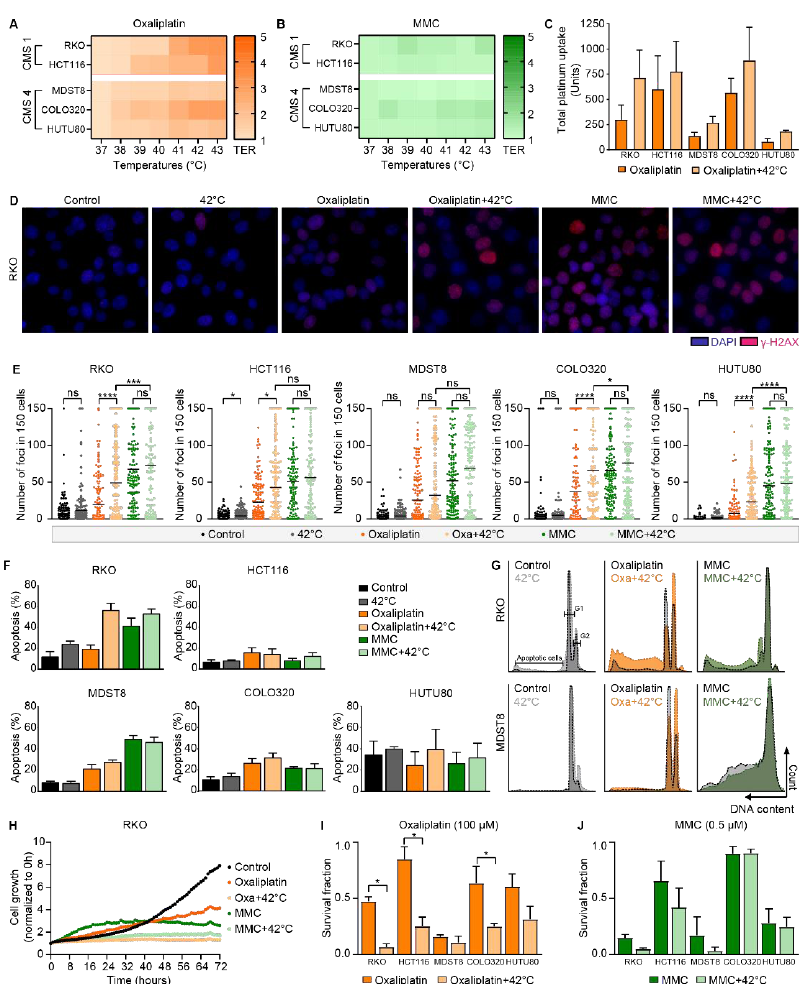
Figure 2. The effect of oxaliplatin is temperature-dependent, mitomycin-C (MMC) is effective at any temperature. To study the temperature-dependent effect of oxaliplatin and MMC, RKO, HCT116, MDST8, COLO320, and HUTU80 cells were exposed to oxaliplatin or MMC under hyperthermic condition for 60 min. Cell viability assays were performed at 48 h after treatment with oxaliplatin ( A ) or MMC ( B ). Thermal Enhancement Ratio (TER) values are demonstrated by a color gradient: a darker color indicates higher TER values. Data represent the mean of 3 independent experiments. ( C ) The cellular uptake of oxaliplatin was assessed by measuring platinum uptake in cells using the CyTOF at 1 h after treatment. Means ± standard error of the mean of 3 independent experiments are presented. ( D ) DNA double strand breaks were measured by nuclear γ-H2AX staining. Representative pictures of RKO cells stained for γ-H2AX are presented. ( E ) Quantification of induced foci in RKO, HCT116, MDST8, COLO320, and HUTU80 cells. Data present the number of foci in 150 cells from 3 independent experiments. Apoptosis levels ( F ) and cell-cycle distribution ( G ) were studied using the Nicoletti assay, which was performed 48 h after treatment. Means ± standard error of the mean of 3 independent experiments are presented. Representative flow charts of RKO and MDST8 cells are depicted. ( H ) Live cell imaging was used to study the growth of RKO cells after treatment. Clonogenic survival assays were performed to assess long-term cell survival 10 days after oxaliplatin ( I ) or MMC ( J ) treatment. Means ± standard error of the mean of 4 independent experiments are presented. * p < 0.05, *** p < 0.001, **** p < 0.0001.